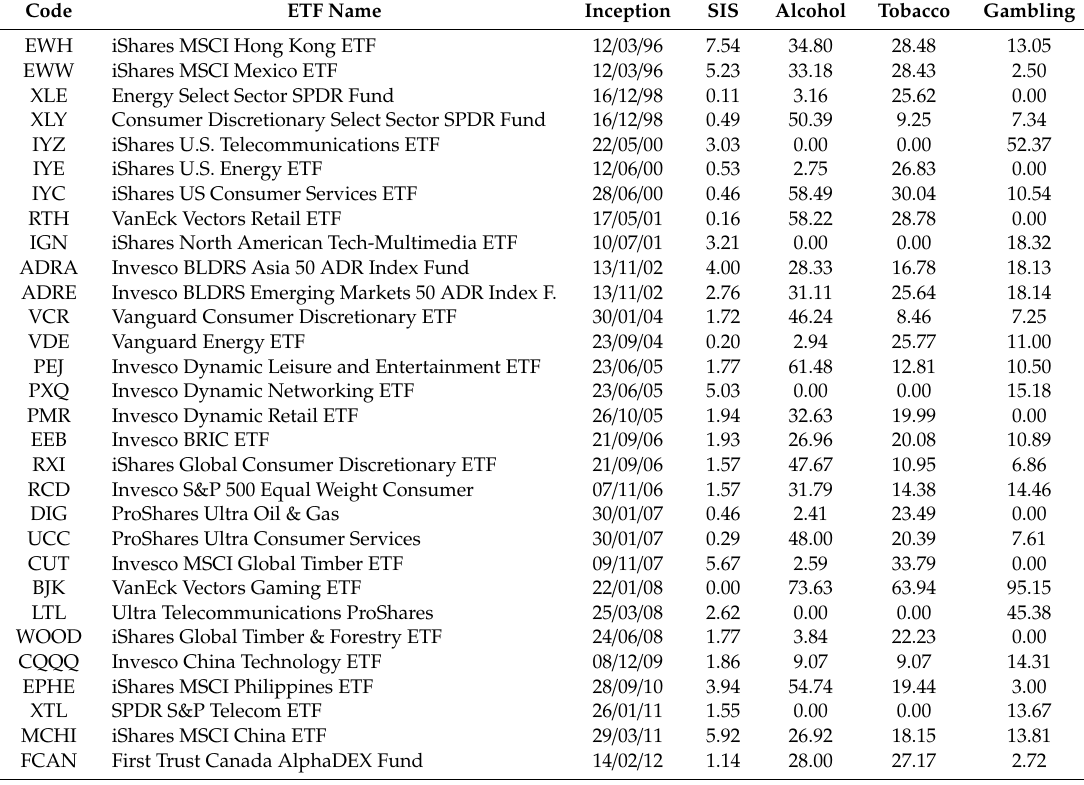
Table 2. Profile of vice ETFs.